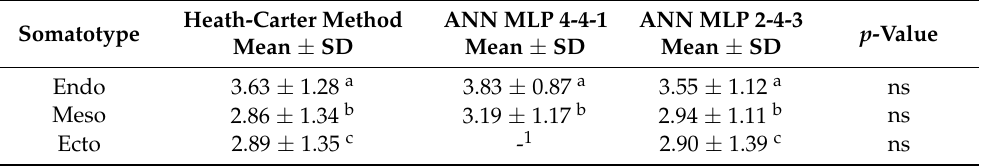
Table 4. Mean values (with standard deviation) of the somatotype in woman calculated from the Heath–Carter method and ANNs (the same letters indicate homogenous groups ( α < 0.05)). Heath-Carter Somatotype